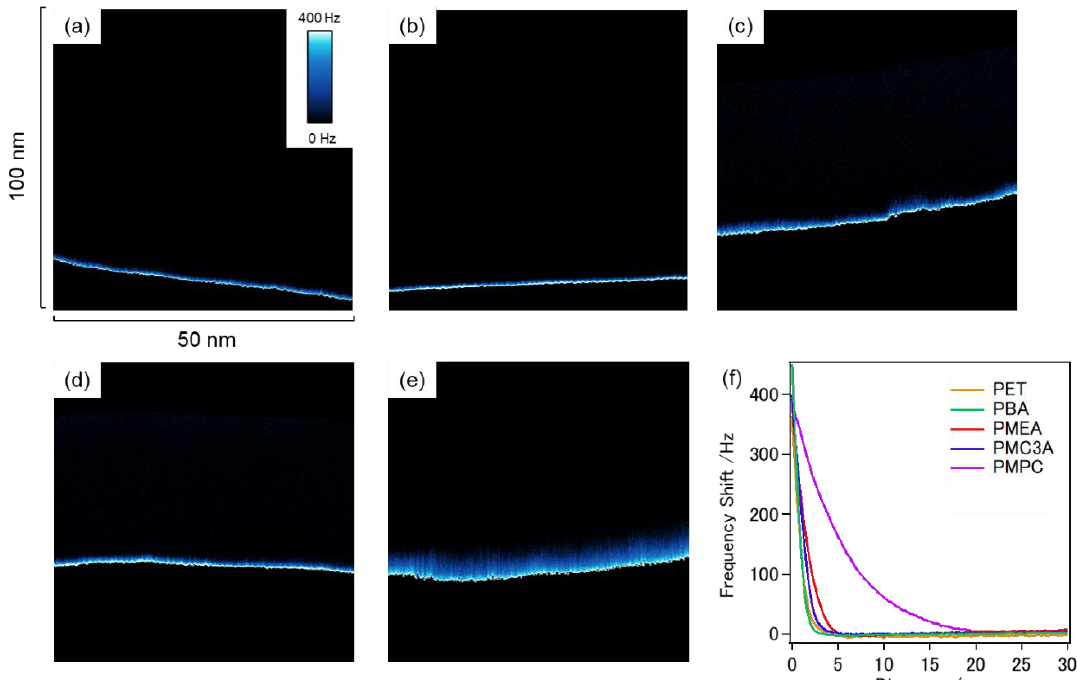
Figure 7. Images of FM-AFM z – x scan on ( a ) PET, ( b ) PBA, ( c ) PMEA, ( d ) PMC3A, and ( e ) PMPC. ( f ) Frequency shift – distance curves obtained from the averaged cross section of ( a – e ).